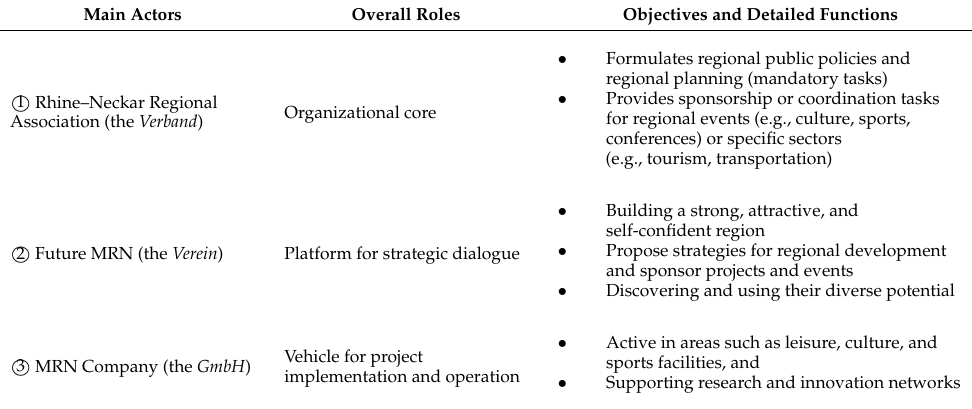
Table 3. Objectives and functions of the main actors in MRN governance.